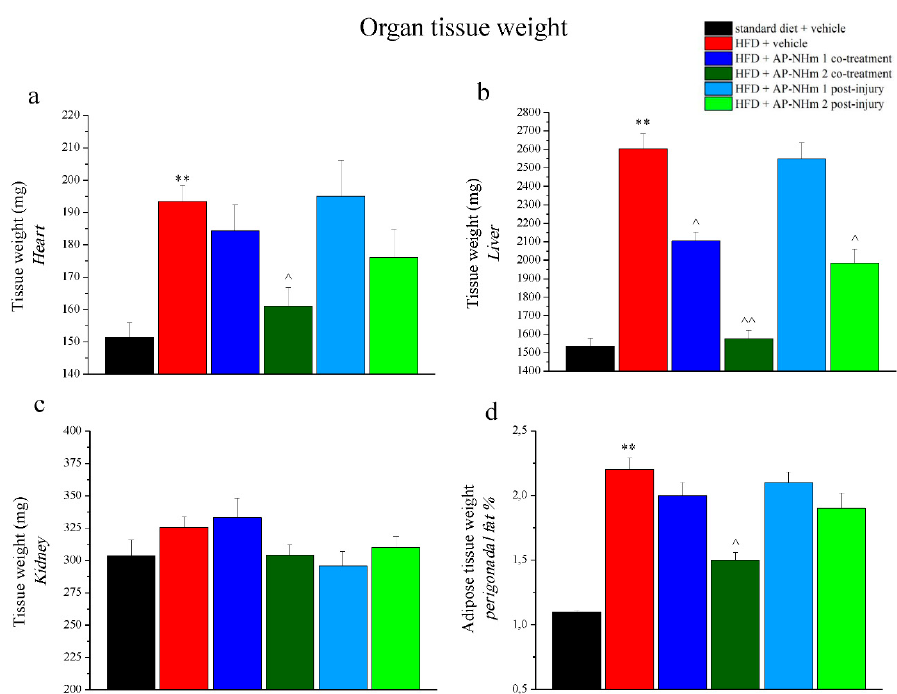
Figure 6. Effects of AP-NHm 1–2, in co-treatment or in post-injury treatment, on organ tissue weight: ( a ) heart, ( b ) liver, ( c ) kidney, ( d ) perigonadal fat pad: on week 12, following in vivo examinations, organs were explanted and weighed. Each value represents the mean ± SEM of 12 mice per group. ** p < 0.01 vs. standard diet + vehicle, ^ p < 0.05 and ^^ p < 0.01 vs. HFD + vehicle. Nutrients 2020 , 12 , x FOR PEER REVIEW